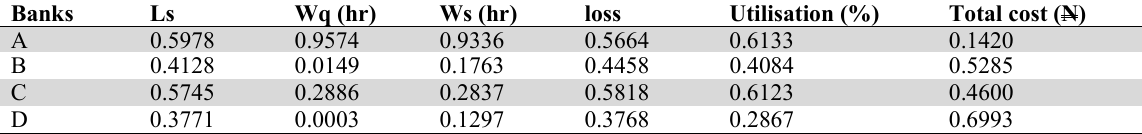
Normalised decision matrix of the study